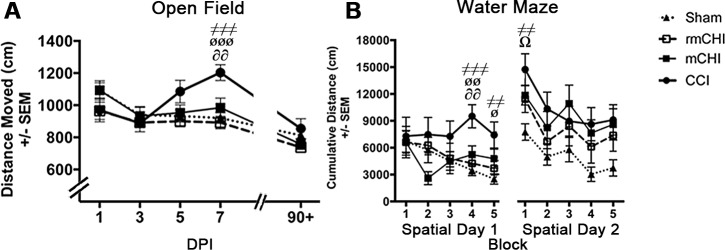
Moderate CCI induced hyperactivity and spatial learning deficits.(A) Moderate CCI mice exhibited hyperactivity in the open field, traveling a significantly greater distance at 7 dpi compared to sham (≠≠≠p<0.001), rmCHI (øøøp<0.001), and mCHI (∂∂p<0.01). CCI-induced hyperactivity was not observed at 90+ dpi. (B) At 90+ dpi, CCI mice exhibited severe deficits in the spatial water maze task, with no evidence of learning the escape platform’s location on day 1. These learning deficits persisted when the platform’s location was changed on day 2. (≠≠p<0.01 for CCI compared to sham, ≠≠≠p<0.001 for CCI compared to sham, øp<0.05 for CCI compared to rmCHI, øøp<0.01 for CCI compared to rmCHI, ∂∂p<0.01 for CCI compared to mCHI, Ωp < .05 for mCHI compared to sham).